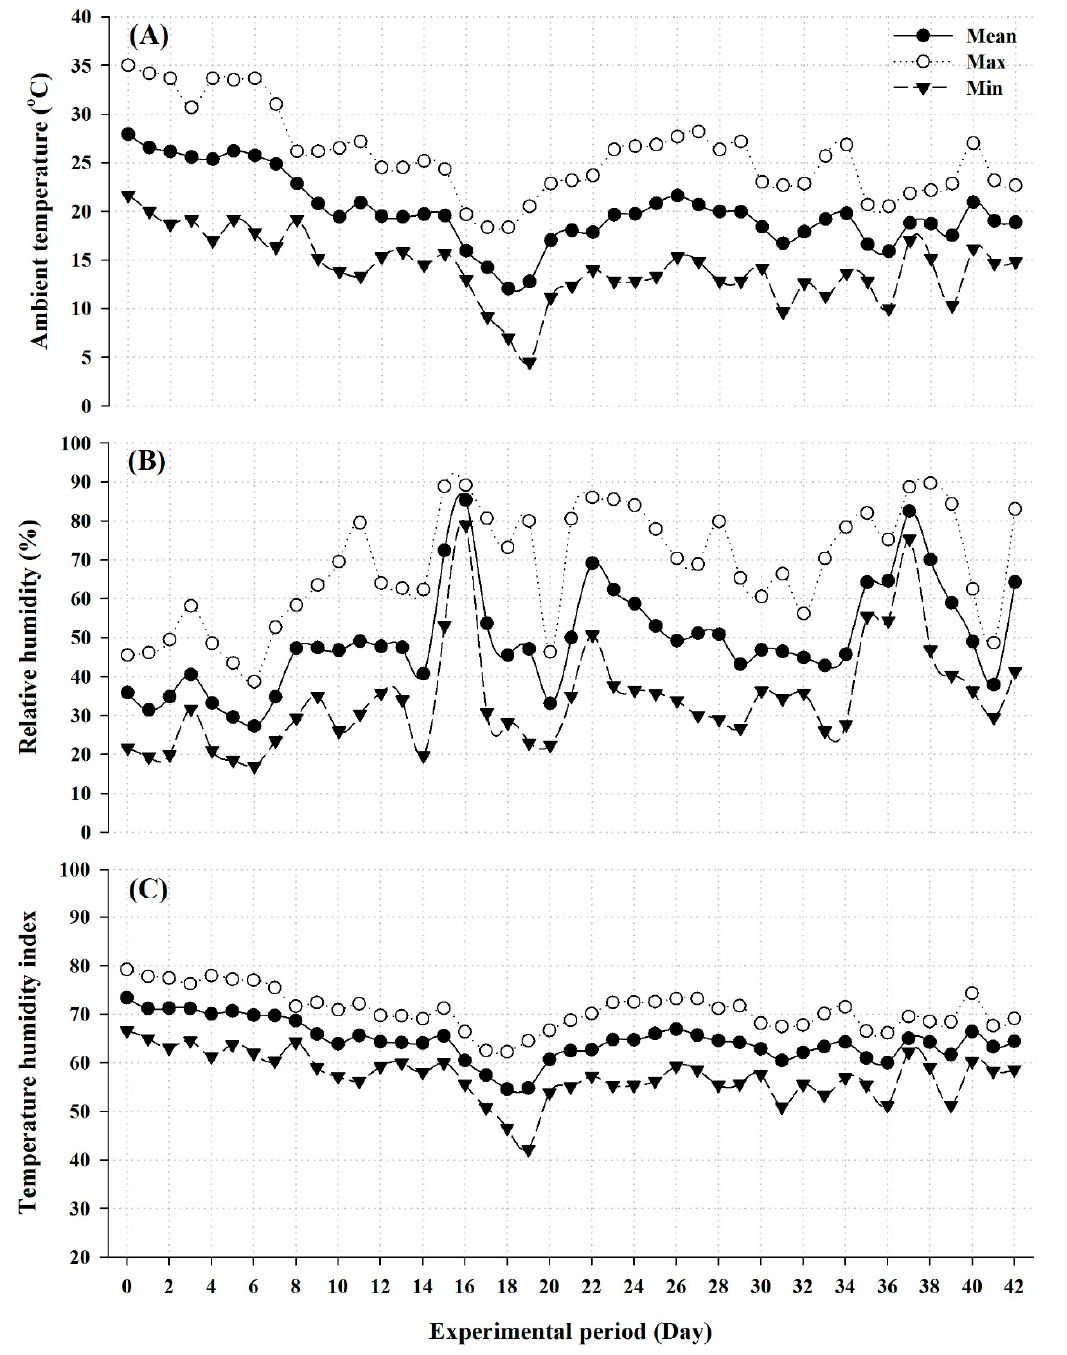
Figure 1. Daily maximum, minimum, and mean ambient temperature ( A ), relative humidity ( B ), and temperature humidity index ( C ) throughout the experimental period.